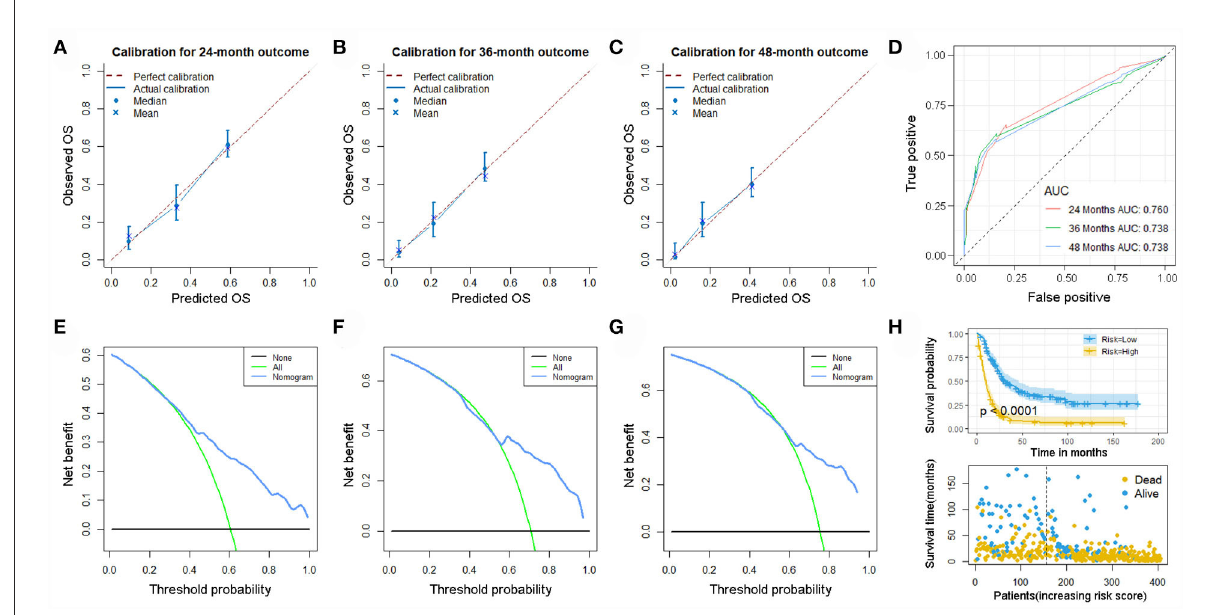
FIGURE13 Calibration curves of 24- (A) , 36- (B) , and 48-month (C) OS; ROC curves (D) ; DCA curves of 24- (E) , 36- (F) , and 48-month (G) OS; and Kaplan–Meier survival analysis (H) in the expanded